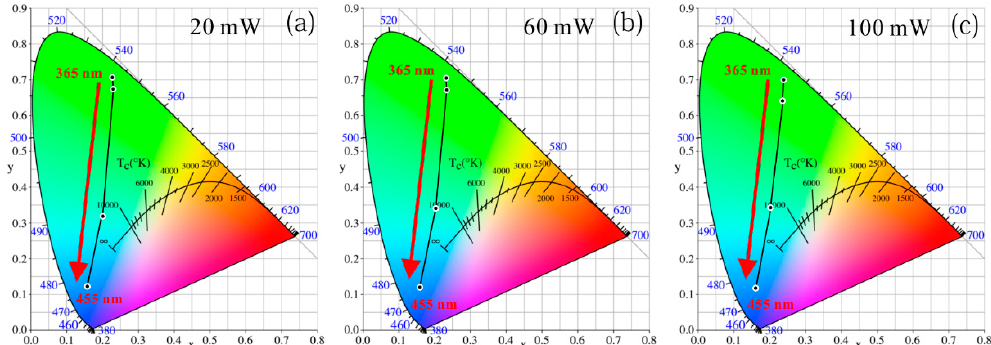
Figure 9. Chromaticity diagram of GQD LED with different excitation wavelengths under equal incident radiant fluxes of ( a ) 20 mW, ( b ) 60 mW, and ( c ) 100 mW.